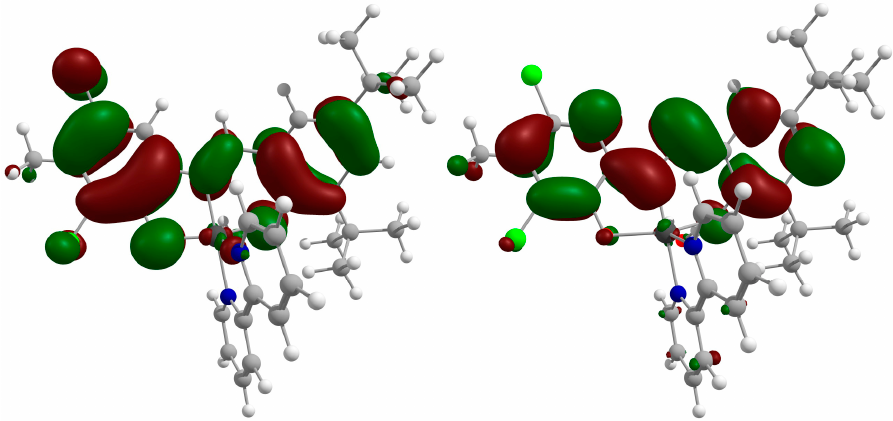
Figure 11. The isosurfaces of HOMO ( left ) and LUMO+1 ( right ) in the optimized structure of 4 .